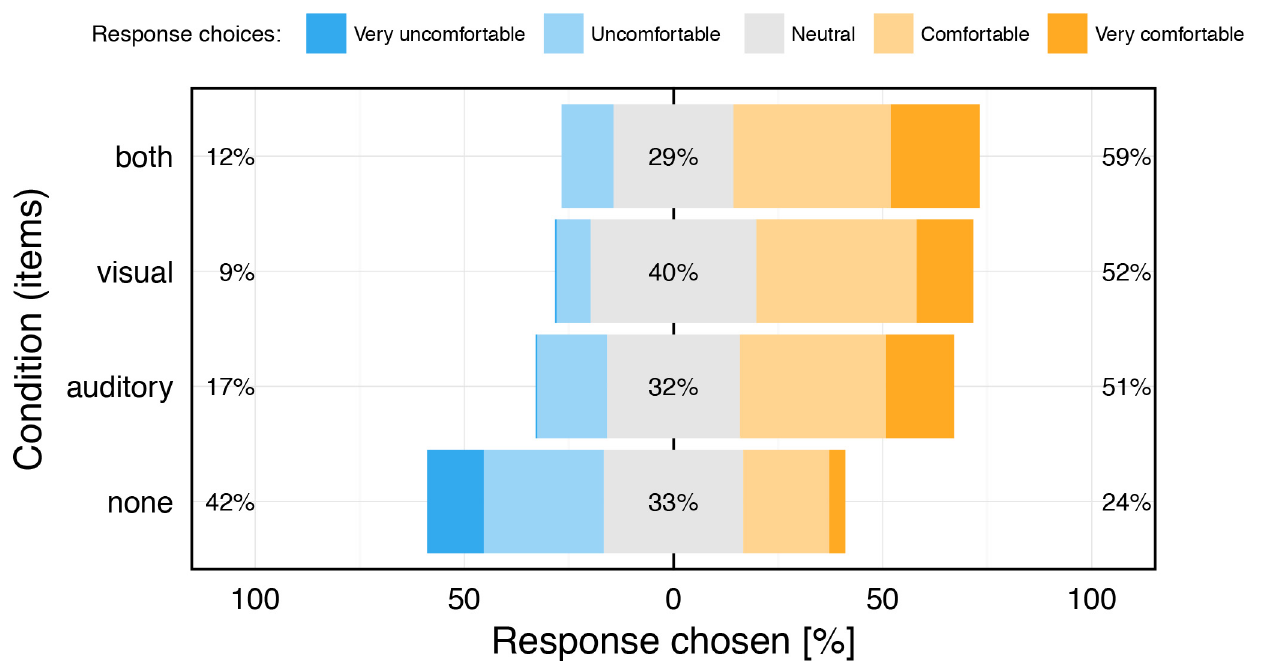
Fig 5. Likert plot of the participants ’ rating of the test, compared across feedback conditions. The “ none ” condition (bottom) leaves the participants in a somewhat negative mood, while any type of feedback is evaluated positively (p < 10 − 7 ).